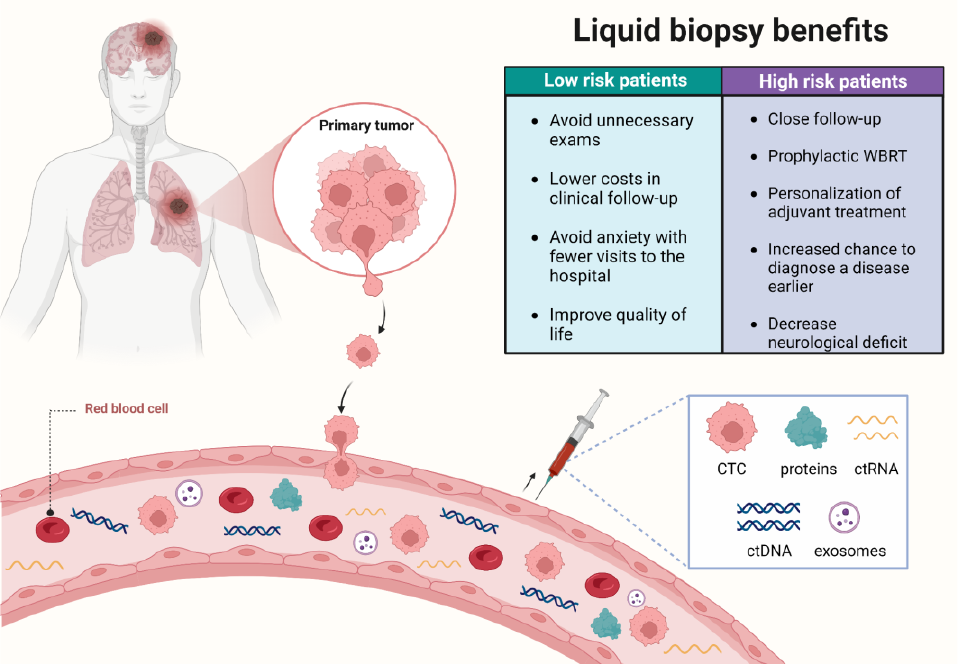
Figure 3. Clinical decisions and benefits for the patients upon using liquid biopsy tests to predict a low or high risk of developing brain metastasis. CTC: circulating tumor cell; ctDNA: circulating tumor DNA; ctRNA: circulating tumor RNA; WBRT: whole brain radiation therapy.